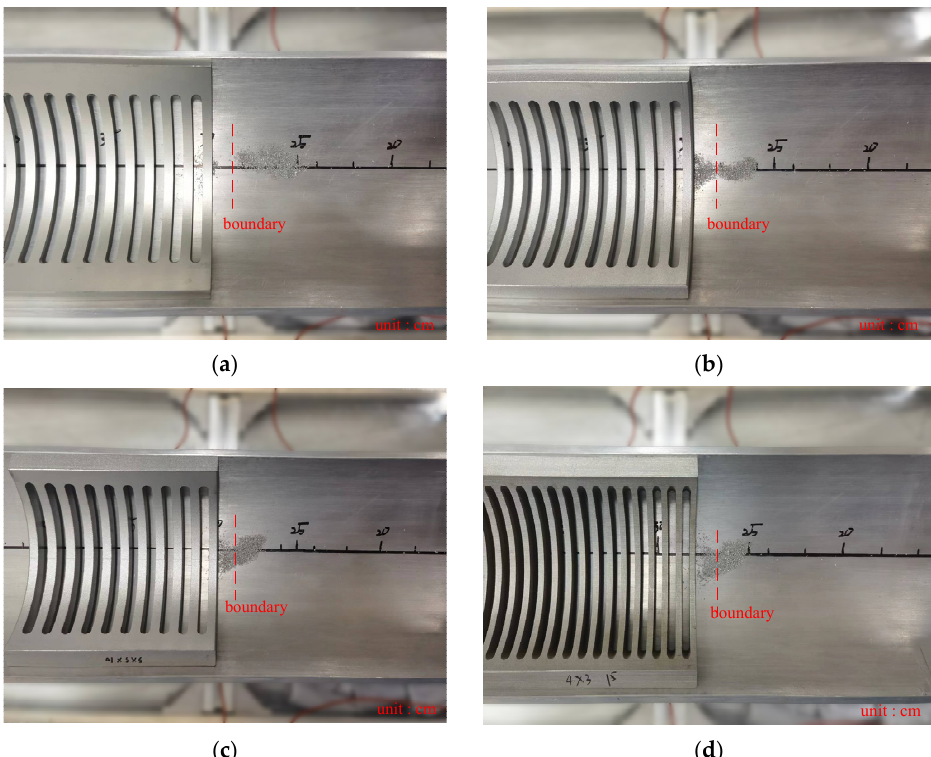
Figure 13. Particle distribution diagram: ( a ) Trap 1, ( b ) Trap 2, ( c ) Trap 3, and ( d ) Trap 4.